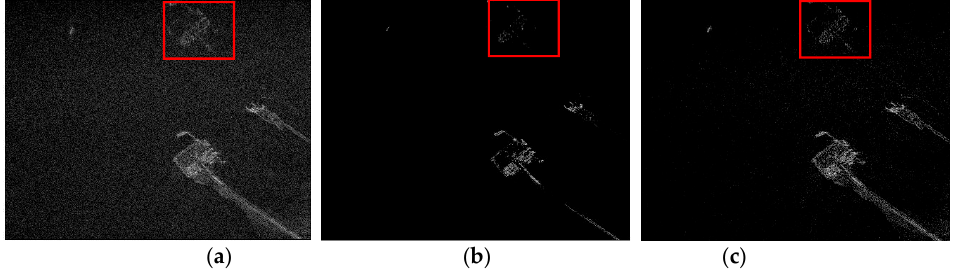
Figure 7. Azimuth ambiguity suppression via different algorithms. ( a ) Matched filtering. ( b ) Raw data-based sparse imaging method. ( c ) Complex image-based sparse imaging method.